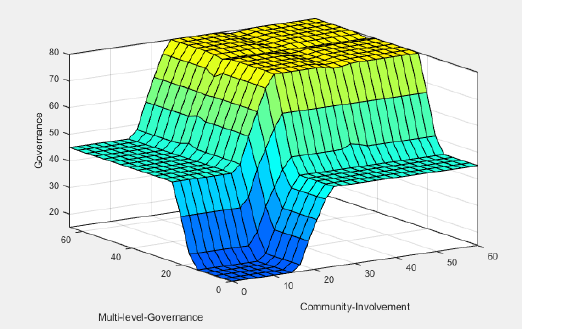
Figure 4b . Rules Surface of governance quality based upon: Multi-level Governance and Community-Involvement